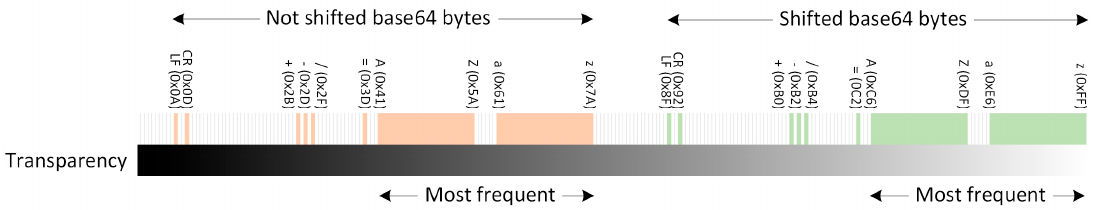
Figure 6. Longitudinally, this figure represents hexadecimal bytes from 0x00 (fully opaque in the alpha channel) to 0xFF (fully transparent). The left half shows where Radix-64 bytes are located (version 1 of the embedding algorithm). The right half shows where they are located in the shifted version of the algorithm.